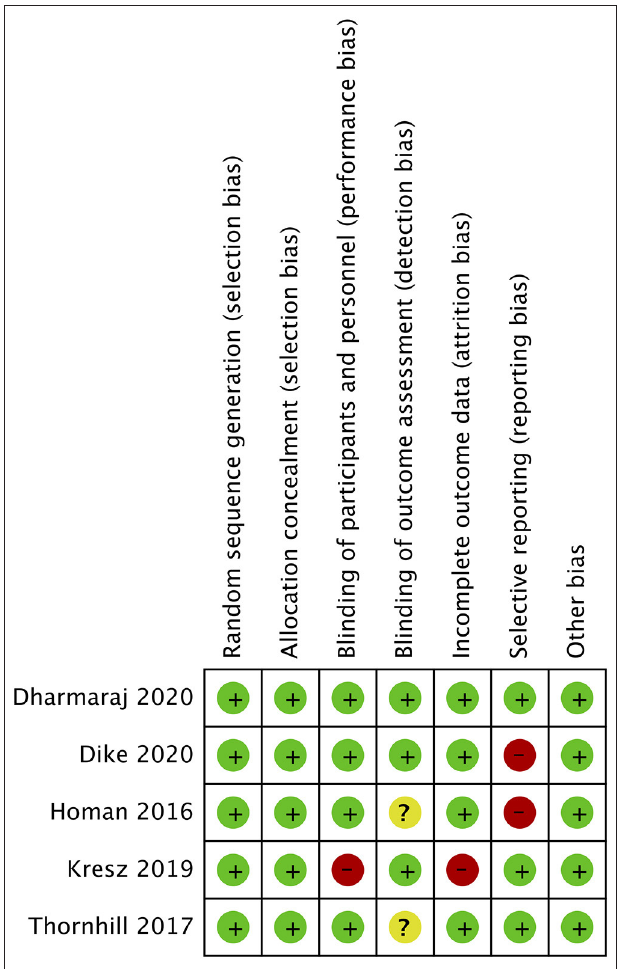
FIGURE 2 | Risk of bias analysis. Red circle, high risk of bias; Yellow circle, unclear risk of bias; Green circle, low risk of bias.